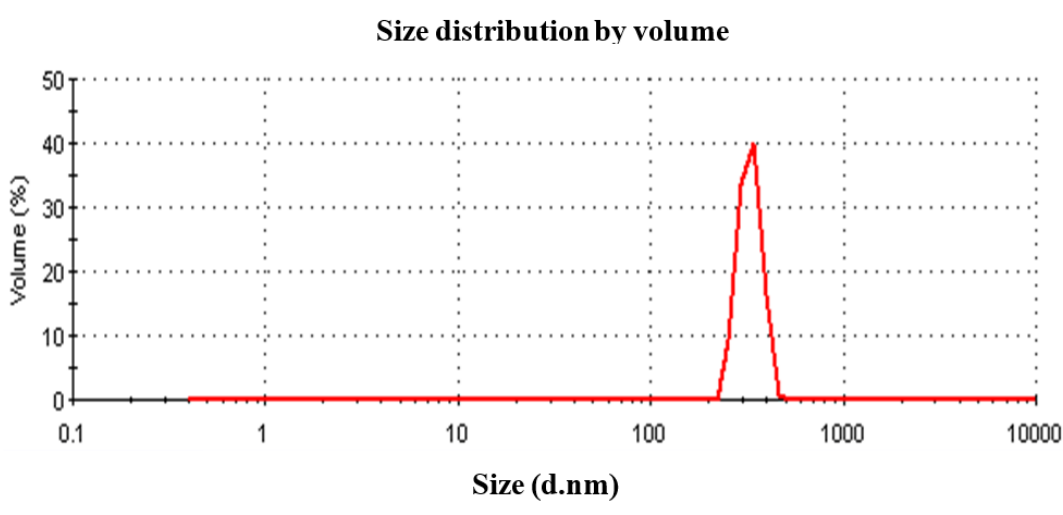
Figure 5. Plant NC Particle size diluted with water and treated with ultrasound for 20 min.